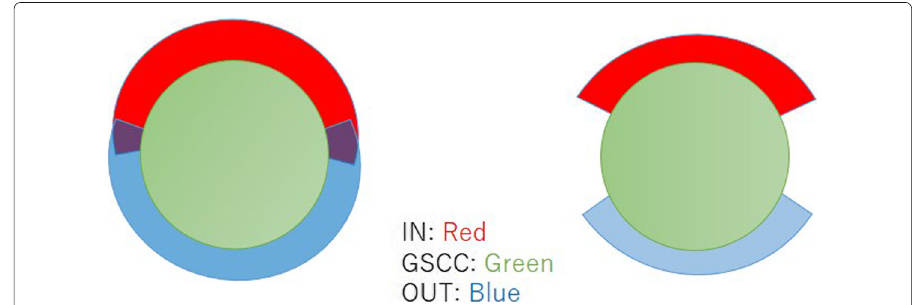
Fig. 4 Illustration of the general ideas on the walnut structure (left) and the bow-tie structure